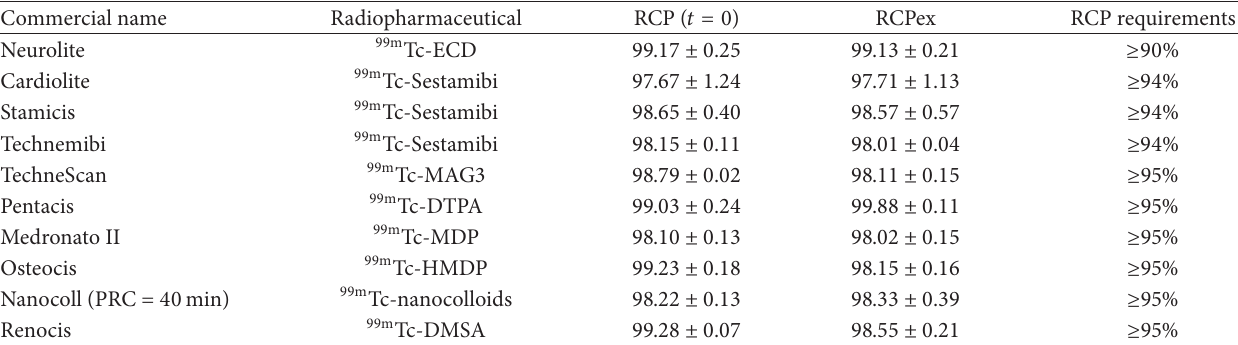
Table 5: RCP of radiopharmaceuticals at 𝑡 = 0 and at the expired time specified by the manufacturer, prepared with the first eluate obtained from DRYTEC GE Healthcare generator.